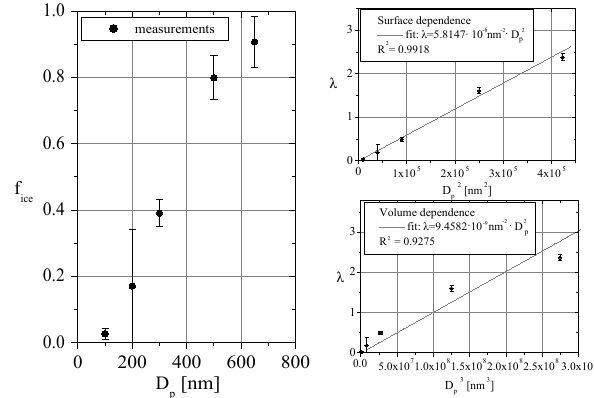
Fig. 7. Ice fraction in the saturation range f ? of the Swedish ice birch pollen washing water particles vs. mobility diameter for T = − 35 ◦ C (left panel). Expected value λ of the Poisson distribution de- scribing the average number of INA macromolecules per Swedish birch pollen washing water particle as a function of particle surface ( D 2 p ) (upper right panel) and as a function of particle volume ( D 3 p ) (lower right panel). R 2 is the correlation